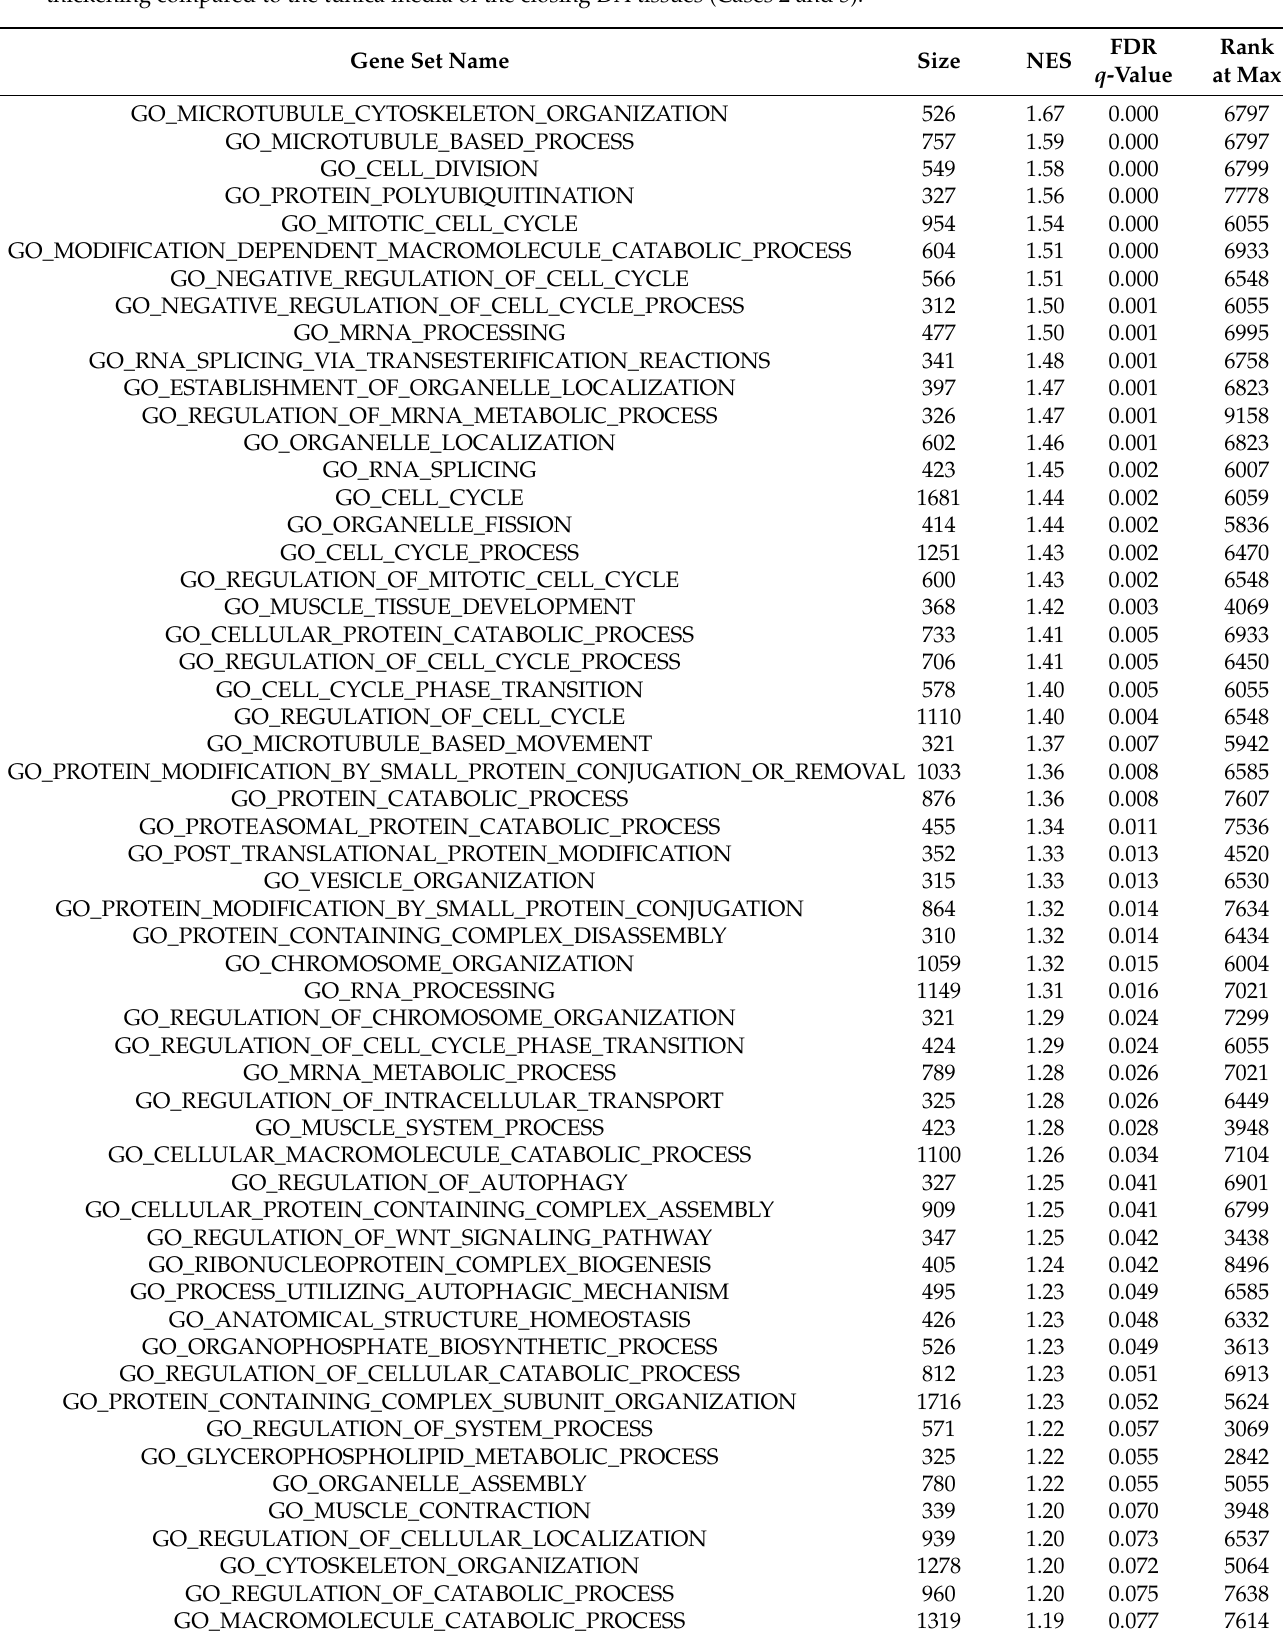
Table 5. Gene Ontology biological process terms (size > 300) that were significantly upregulated (FDR < 0.25) in the intimal thickening compared to the tunica media of the closing DA tissues (Cases 2 and